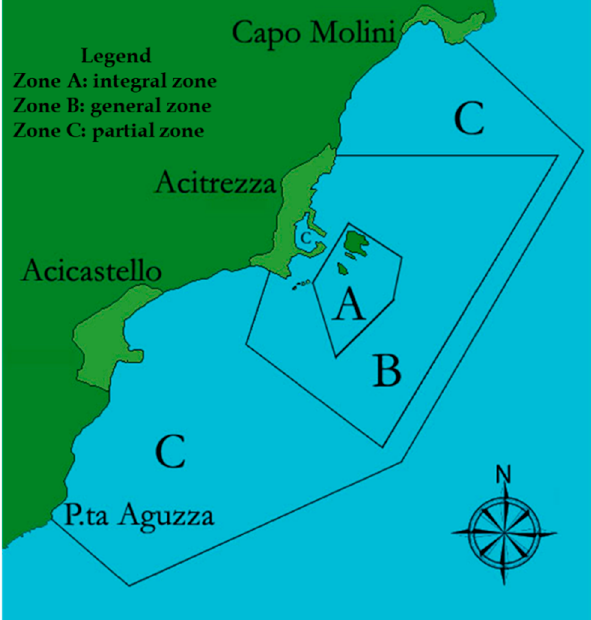
Figure 1. The three protection zones of the MPA Isole Ciclopi.